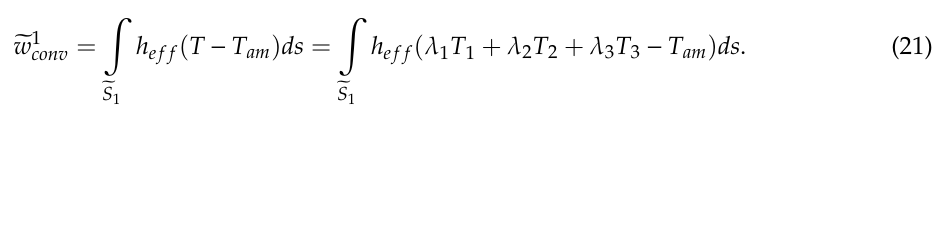
1 , (cid:101) S 2 , (cid:101) S 3 . Contour triangles on the